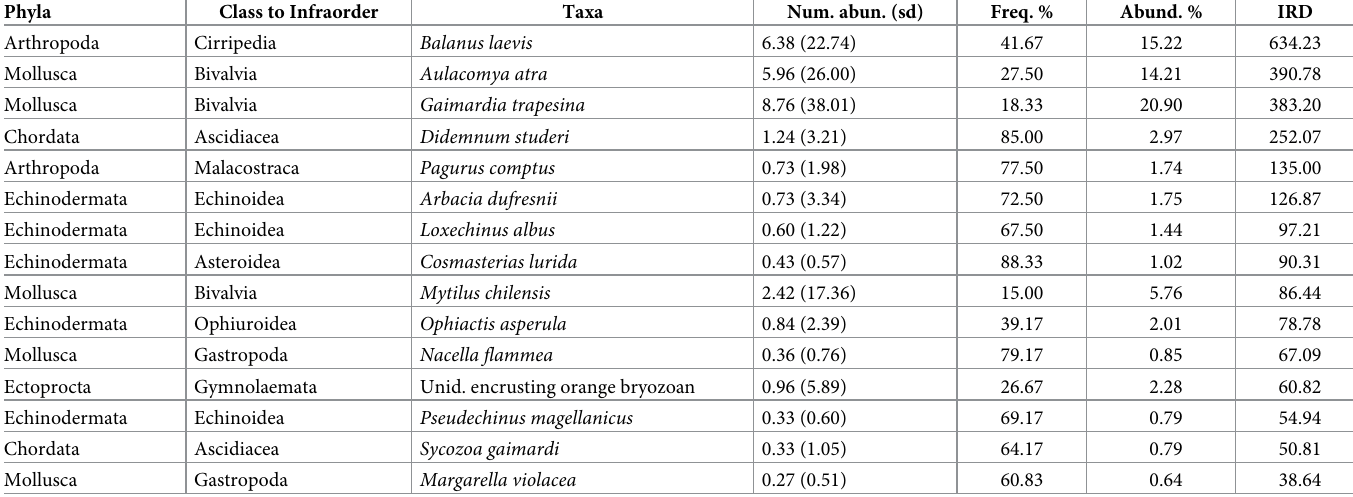
Table 2. Top 15 benthic taxa overall among all transects (n = 120). Taxa are ordered by index of relative dominance (IRD) = % frequency of occurrence (Freq. %) x % numerical abundance (Abund.